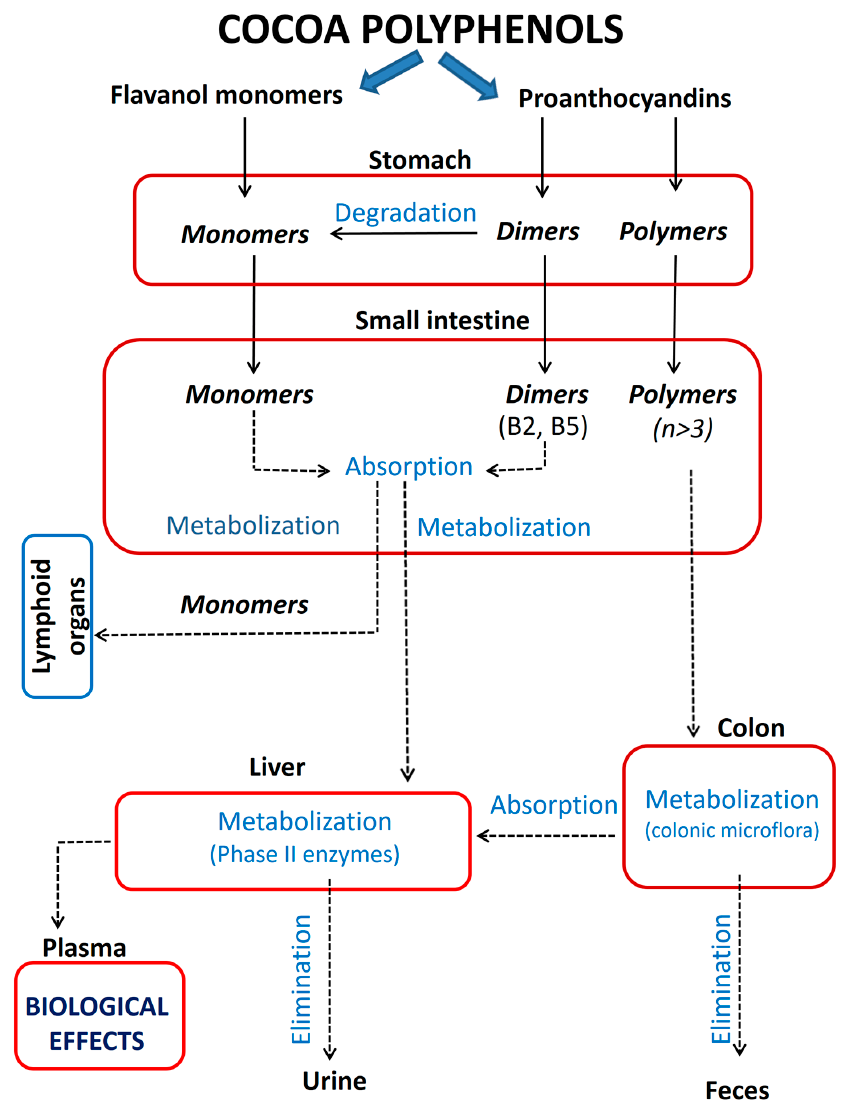
Figure 4. Pharmacokinetic profile of cocoa polyphenols.